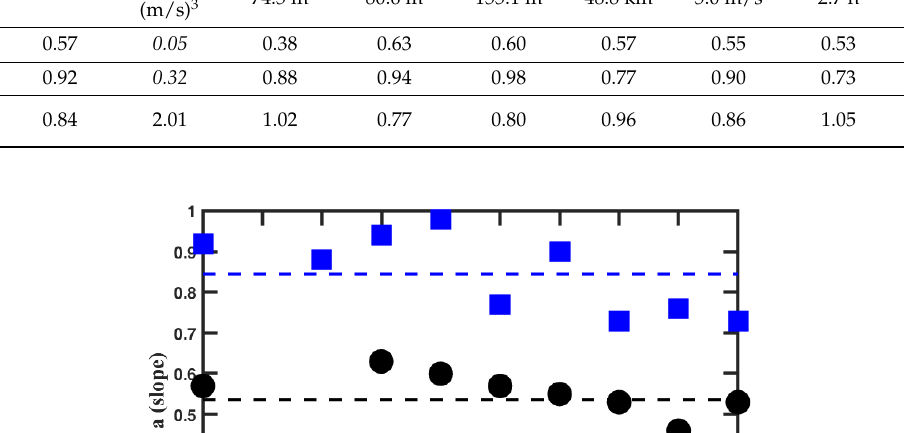
Table 1. Model sensitivity to TC and ocean parameters (see text for details). All r 2 and slope “a” values are significant at the 99.9% confidence level, except for the fixed V o3 case (italicized numbers). r mw /U h V o3 V o3 and h Fixed (Z 20 ) r mw Fixed U h Fixed (Figure 4) Fixed Varies h 1 Vary